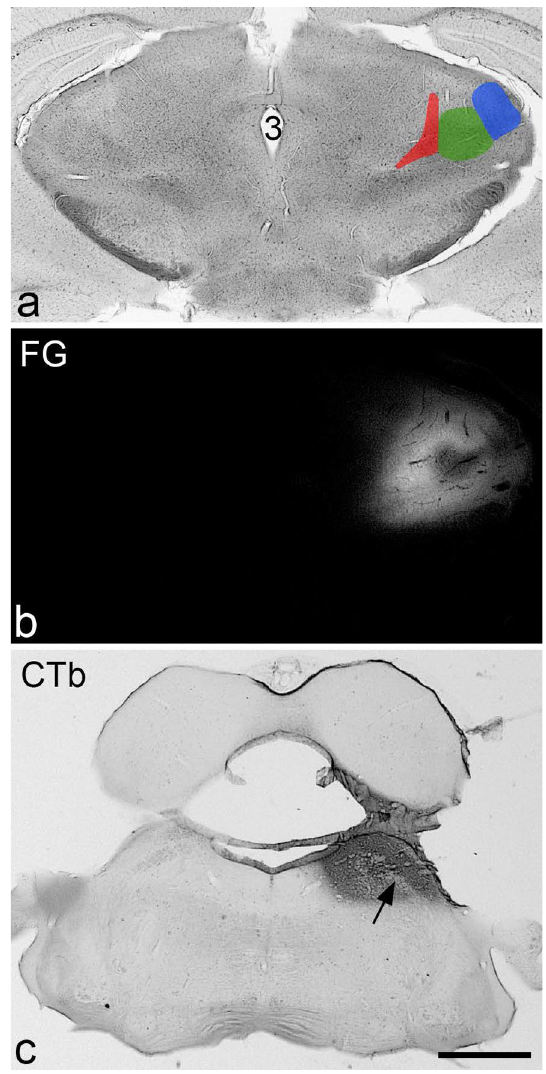
Figure 1. Representative injection sites in the thalamus and brainstem from one of the experiments (#6). ( a , b ) Brightfield and fluorescence and images of a section through the diencephalon reveal the extent of the Fluorogold (FG) injection. Areas shown in red, green and blue correspond to the posterior triangular nucleus of the thalamus, and the medial and lateral geniculate nuclei, respectively. The 3rd ventricle is also indicated (3). ( c ) A section through the pons that has been reacted by an immunoperoxidase method to reveal cholera toxin B subunit (CTb). The arrow indicates the position of the superior cerebellar peduncle. Scale bar ( a–c ) = 1